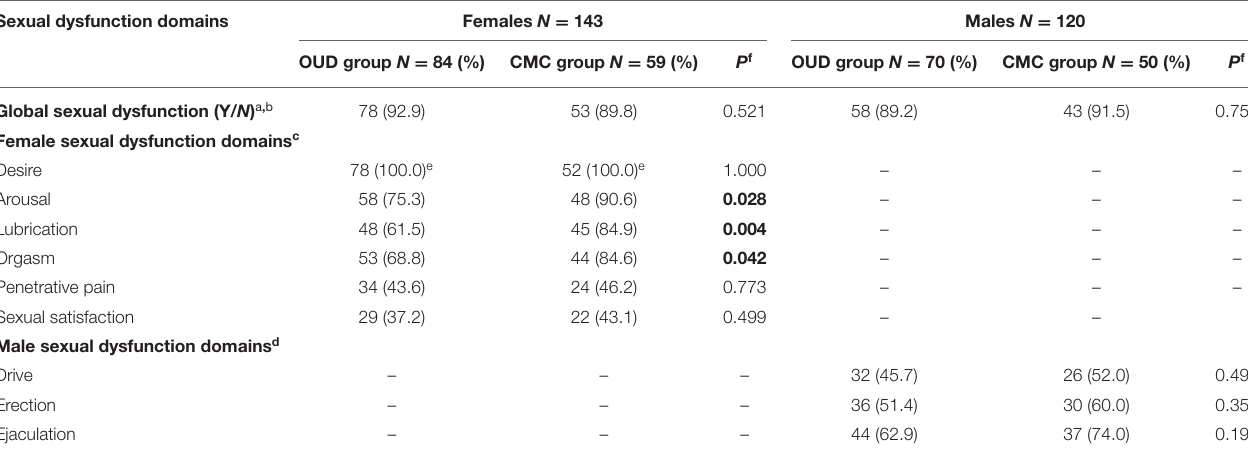
TABLE 3 | Sexual dysfunction characteristics among males and females in the study